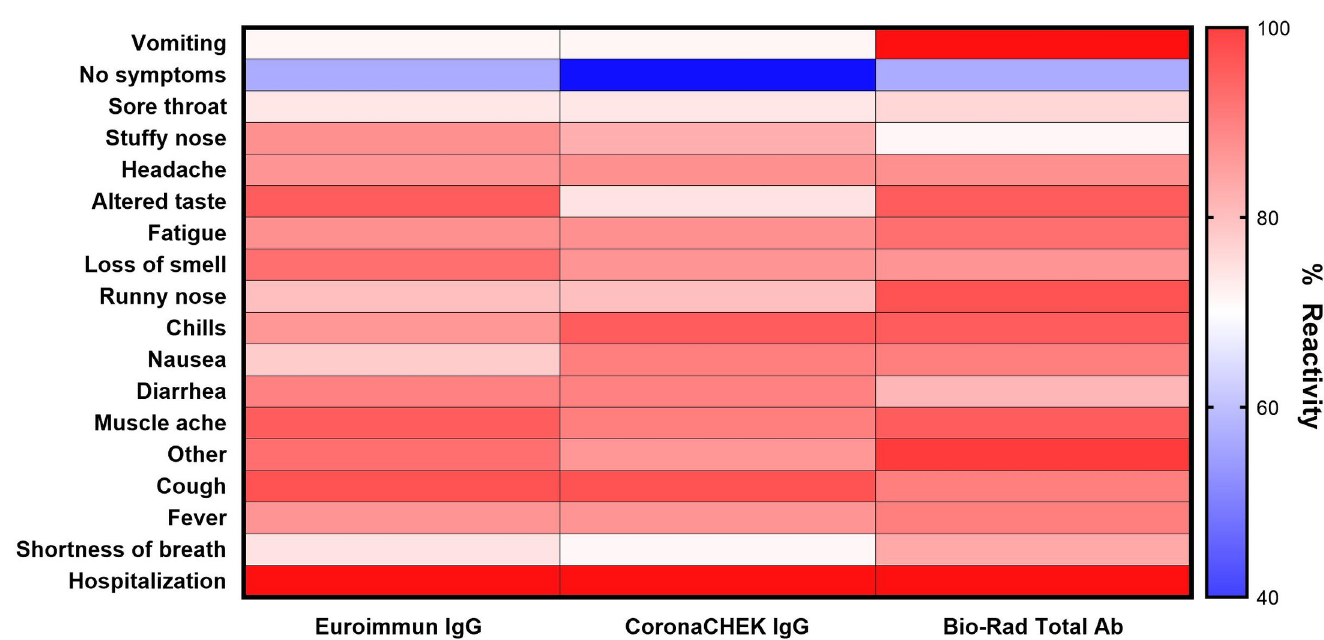
Fig 2. Reactivity of antibody assays by presenting symptoms. Percent reactivity was calculated by dividing the number of individuals with positive antibody results reporting the indicated symptom by the total number of individuals reporting the indicated symptom. https://doi.org/10.1371/journal.pone.0264298.g002 ( Table 2 ). In contrast, sore throat was significantly associated with a lack of detectable anti-